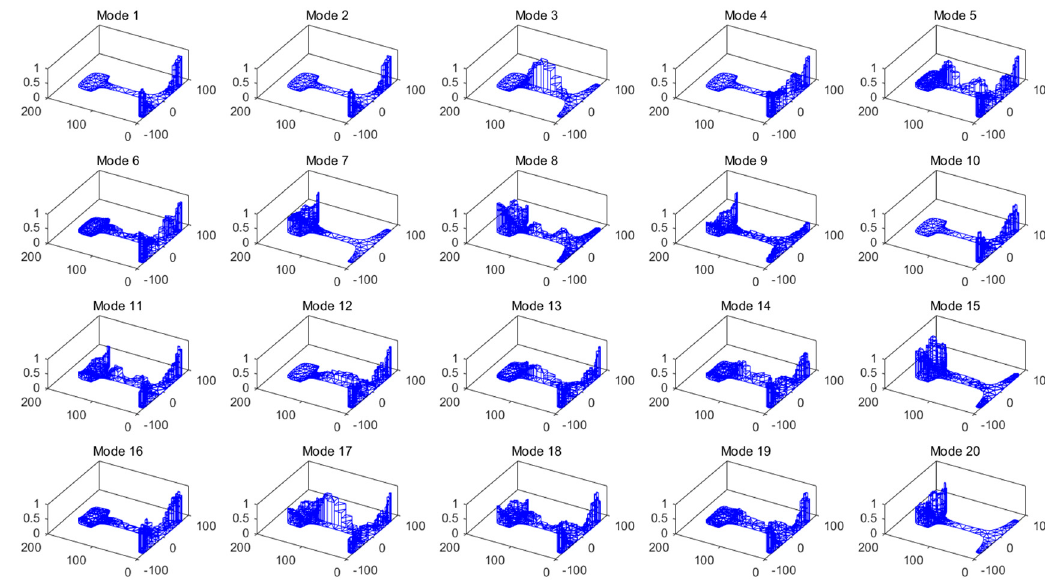
Figure 3. Strain energy distribution diagram of modes.